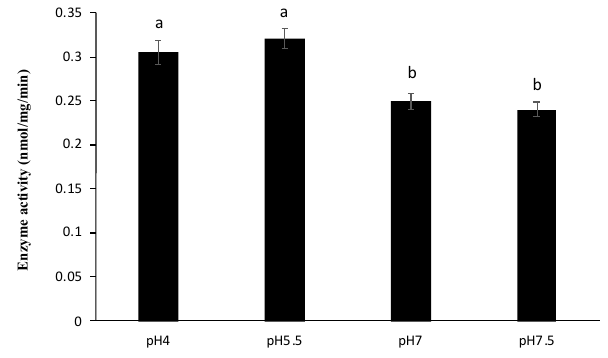
Figure 1. Dephosphorylation of PA FLA by sweet potato PAP in dif- ferent pH conditions. The phosphatase assay was performed at 37°C for 4 hours in a 1-mL reaction mixture containing 4 μL of the enzyme (46.4 μg), 1 μg of PA FLA substrate, and 50 mM Na-acetate (pH 4.0 and 5.5) or Bis-Tris (pH 7.0) or Tris-HCl (pH 7.5). Enzyme ac - tivity was defined as the amount of enzyme required to liberate 1 nmol of inorganic phosphate per min divided by mg of the protein. The data were expressed as the mean and standard errors from three experiments. PA FLA, Pseudomonas aeruginosa flagellin; PAP, purple acid phosphatase. a,b Means lacking common letters differ significantly (p<0.05).